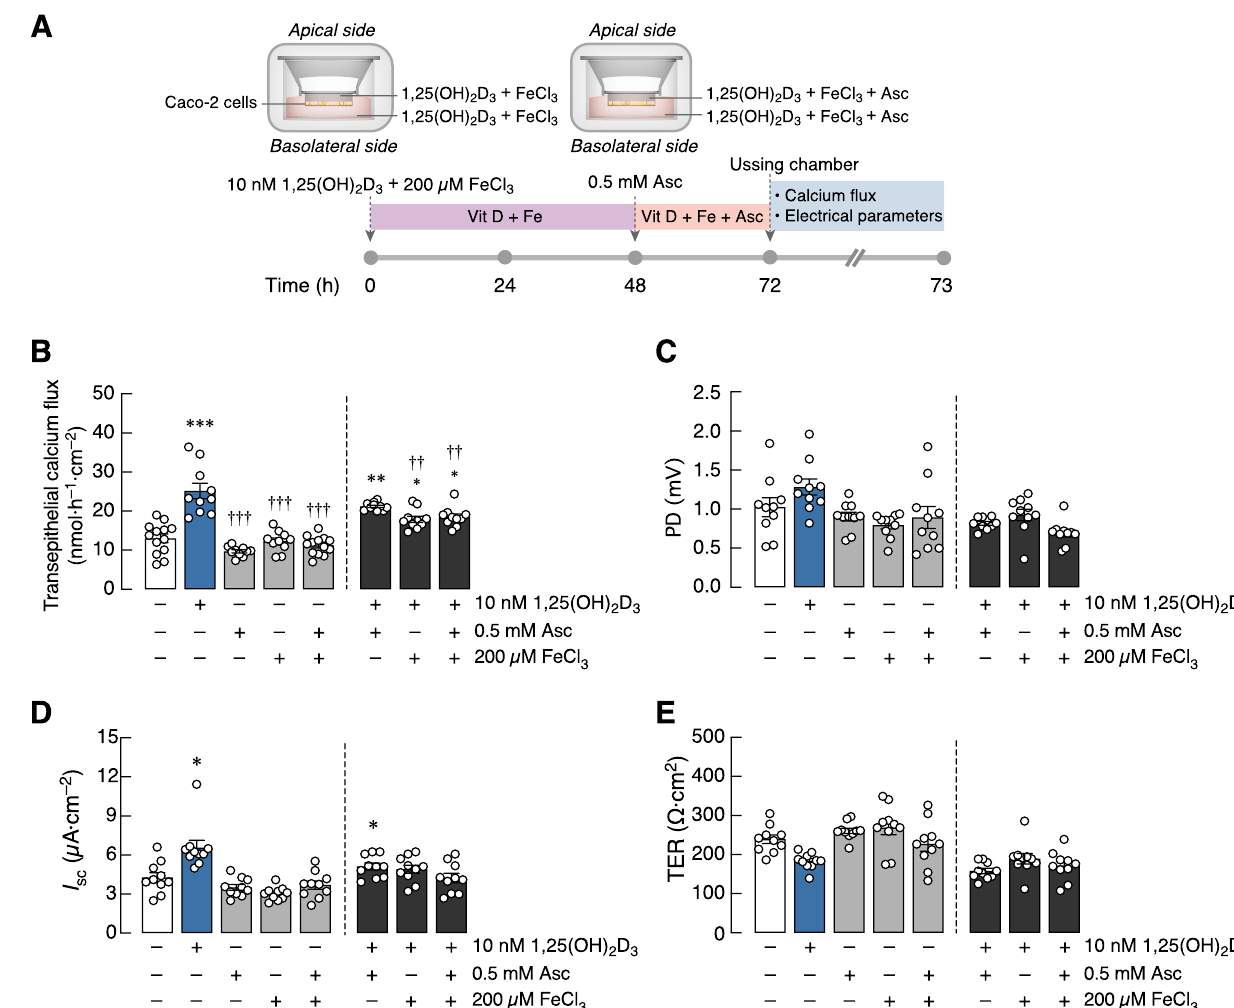
Fig 4. Calcium transport across Caco-2 monolayer combine treated with 1,25(OH) 2 D 3 , ascorbic acid (Asc), and FeCl 3 . (A) Experimental timeline (please see text for detail). (B–E) Transepithelial calcium transport and epithelial electrical parameters (PD, I sc , and TER) in Caco-2 monolayers with or without 10 nM 1,25(OH) 2 D 3 , 200 μ M FeCl 3 , and 0.5 mM Asc. PD values were the magnitudes of potential difference (the apical side being negative with respect to the basolateral side), and glucose made the apical side more negative. (n = 10; � P < 0.05; �� P < 0.01; ��� P < 0.001 compared with the control group (white bar); †† P < 0.01; ††† P < 0.001 compared with the 10 nM 1,25(OH) 2 D 3 -treated group (blue